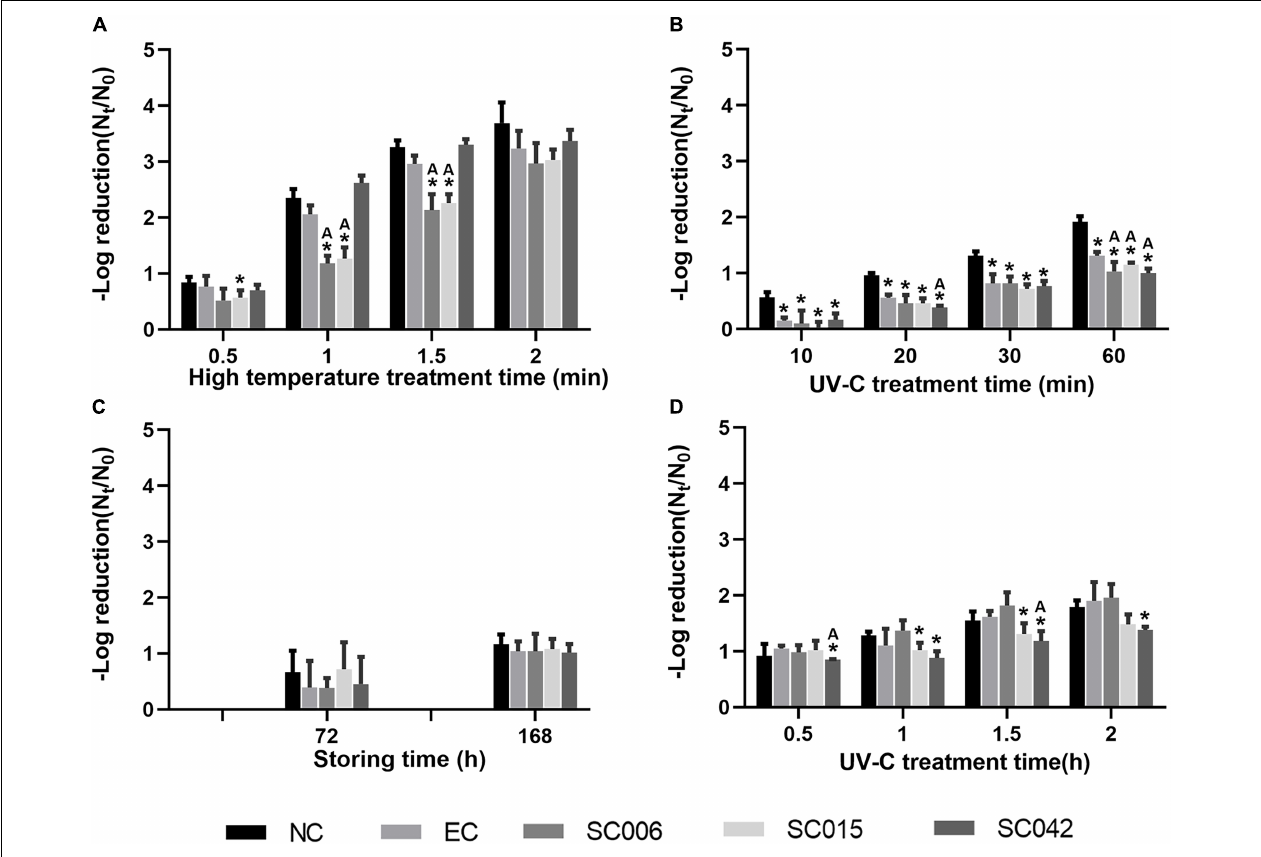
FIGURE 3 | Effects of viral–bacterial interaction on NoV reduction. (A) Simulation of hot rinsing disinfection; (B) simulation of UV irradiation disinfection; (C) adherence on the lettuce and simulation of normal storage; (D) adherence on the lettuce and simulation of UV irradiation. NC means negative control, which is PBS buffer without bacterial cells; EC means bacterial control, which is prepared with E. coli ATCC15597 suspension. The * symbol means significantly varied from the NC group. The “A” symbol means significantly varied from the EC group. Students’ t -test is used for the significance testing, p <